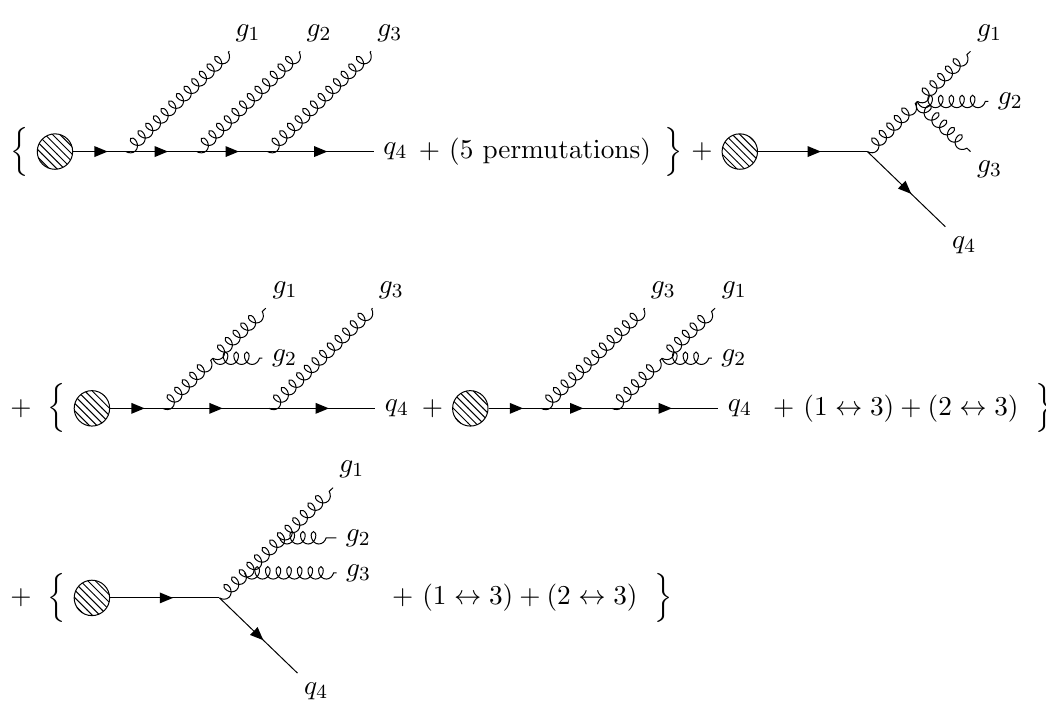
Figure 2 . The Feynman diagrams contributing to the off-shell current q → g